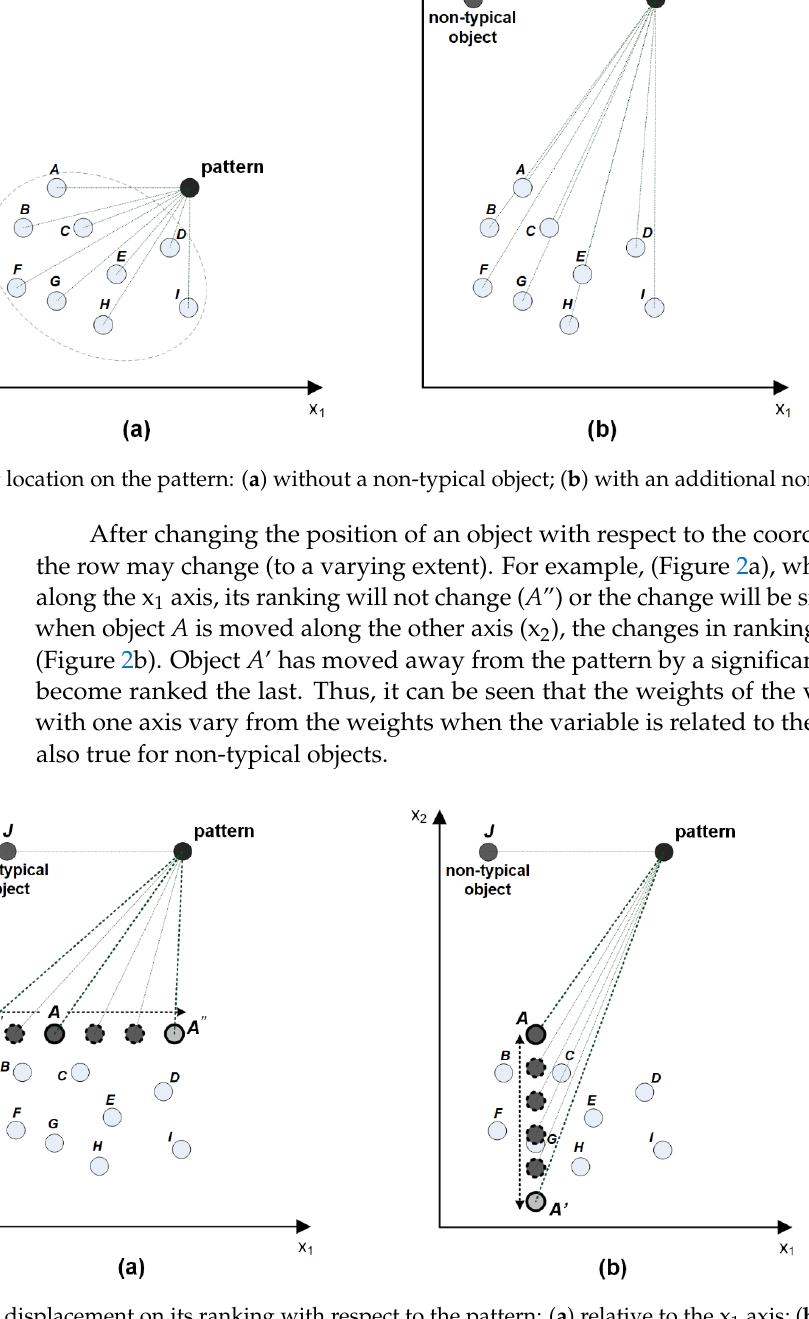
Figure 2. Effect of object displacement on its ranking with respect to the pattern: ( a ) relative to the x 1 axis; ( b ) relative to the x 2 axis.